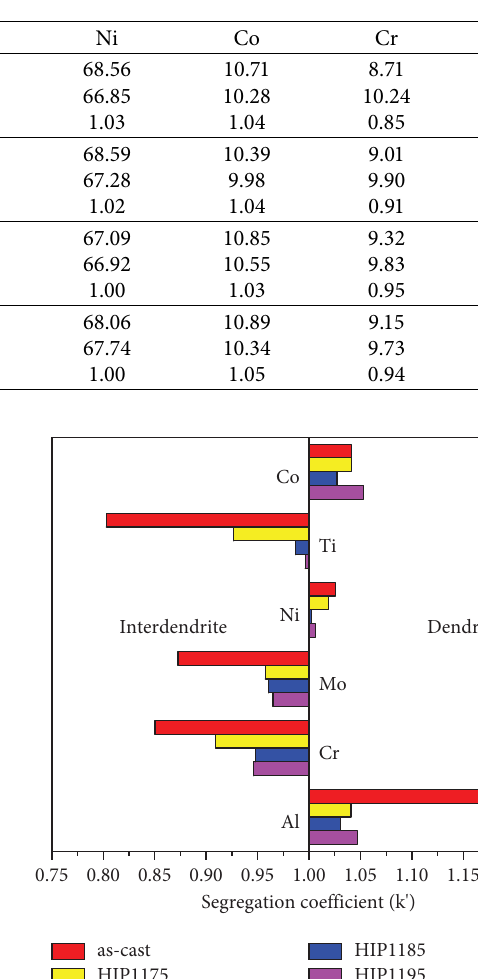
Table 3: Dendrite compositions of the K417G superalloy in as-cast, HIP1175, HIP1185, and HIP1195 conditions were determined by EPMA (wt%), as well as microsegregation coefcients, k ′ , the ratio of the concentration (wt%) of an element in the dendrite core to that in the interdendritic region.